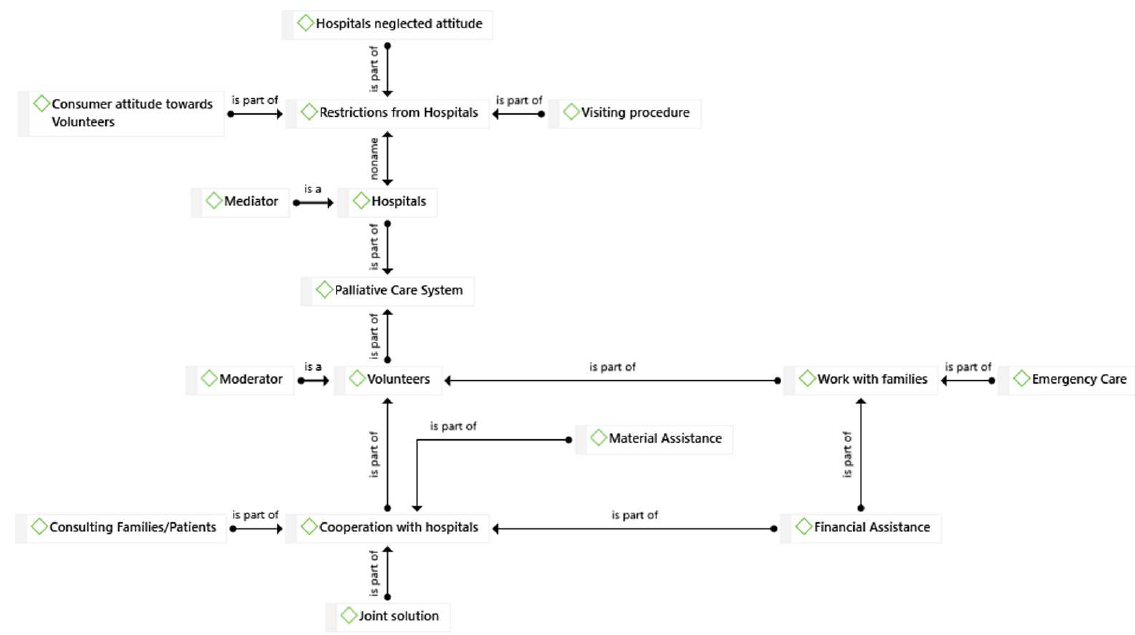
Figure 1. Participants of palliative care